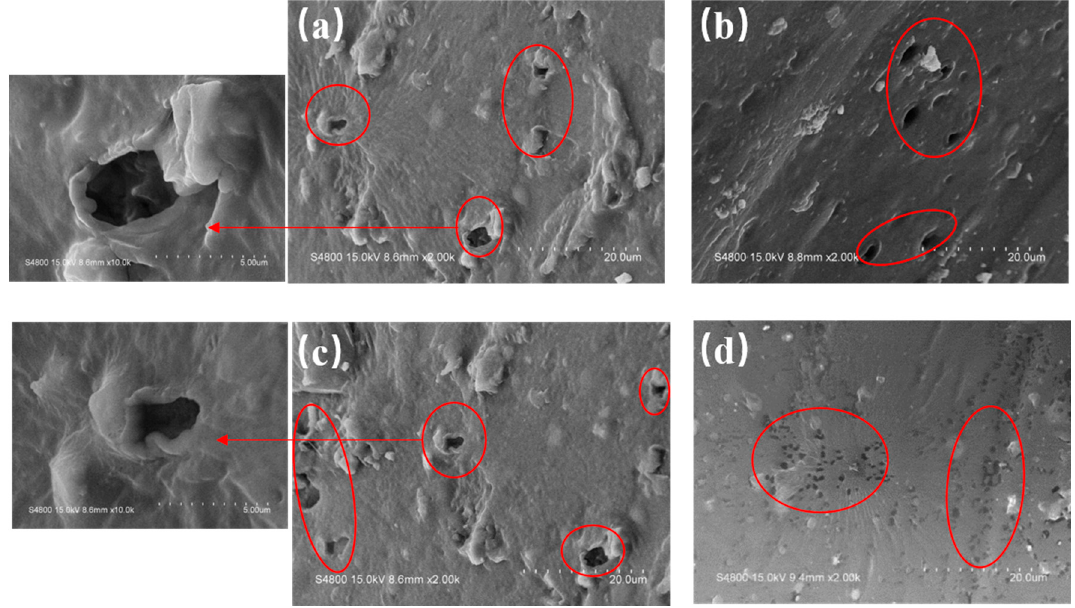
Figure 14. SEM images of surface morphology of the PVC biofilm carrier: ( a ) PVC/cPAM, ( b ) PVC/cPAM-3, ( c ) PVC/cPAM-12, and ( d ) PVC/cPAM-15. The red circle is the hole.